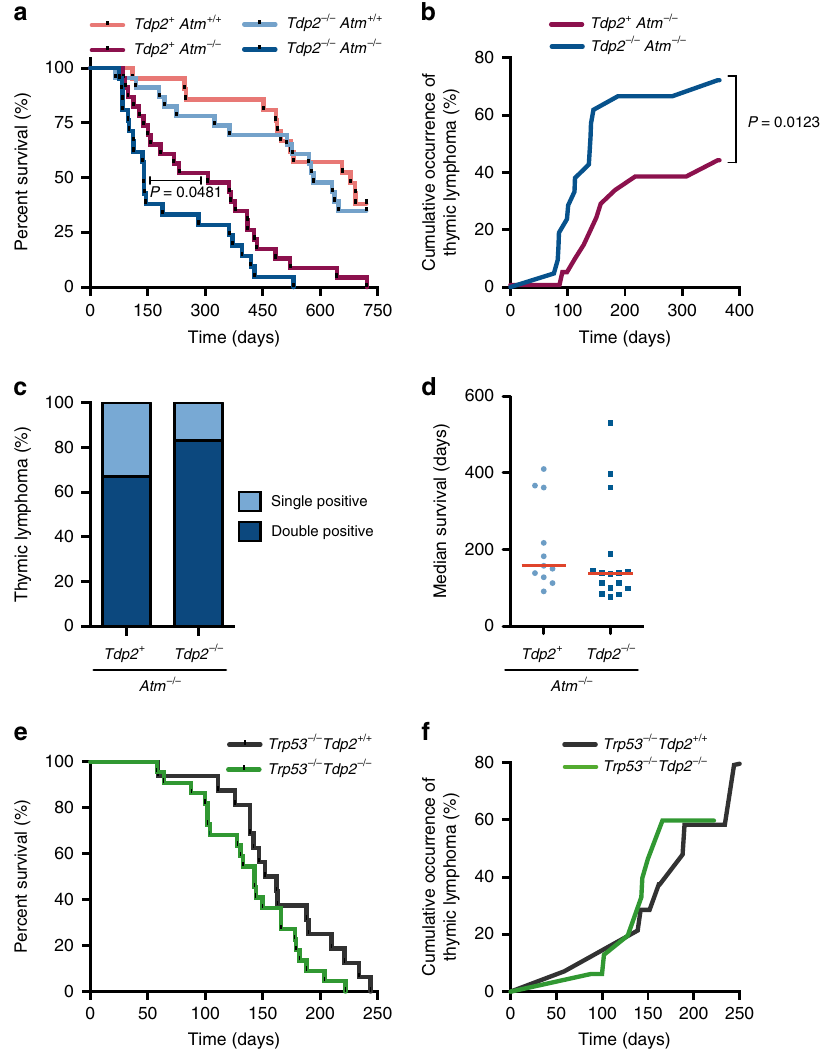
Fig. 2 TDP2 de fi ciency increases thymic cancer predisposition of Atm − / − but not of Tpr53 − / − mice. a , b Kaplan – Meier survival curve ( a ) and cumulative occurrence ( b ) of thymic tumours during the 1 st year of life of at least 20 mice with the indicated Tdp2 and Atm genotypes. n = 21 ( Tdp2 + / + Atm + / + ) , n = 23 ( Tdp2 − / − Atm + / + ) , n = 23 ( Tdp2 + / + Atm − / − ), n = 21 ( Tdp2 − / − Atm − / − ). Tdp2 + indicates both Tdp2 + / + and Tdp2 + / − genotypes. Statistical signi fi cance by two-sided Wilcoxon test is indicated. c Percentage of tumours composed by immature CD4 + CD8 + double positive, or CD4 + /CD8 + single positive lymphocytes in the indicated genotypes. Thymocytes were selected by size and complexity prior classi fi cation by high or low CD4 and CD8 markers (see Supplementary Fig. 1a for gating strategy). d Median life-span of Tdp2 + / + Atm − / − and Tdp2 − / − Atm − / − mice affected by a thymic tumour ( n = 11 and n = 16 for Tdp2 + / + Atm − / − and Tdp2 − / − Atm − / − mice respectively). e Kaplan – Meier survival curve and f cumulative incidence of thymic tumours of the indicated Tdp2 and Trp53 genotypes ( n = 16 for Tdp2 + / + and n = 22 for Tdp2 − / −